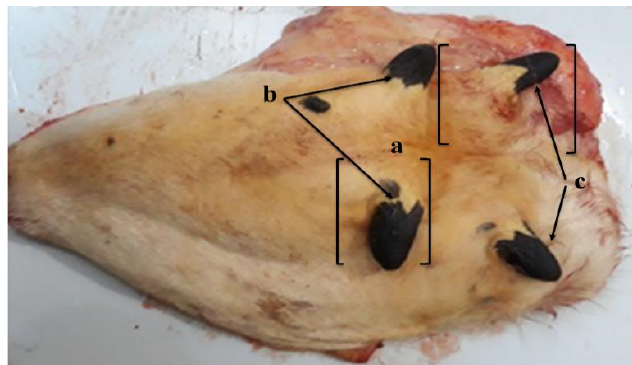
Figure 1. Photograph of ventral view in non-lactating udder of local Iraqi cow shows the external features: (a) intra mammary groove, (b) Fore teats of the fore quarters, (c) Hind teats of the hind quarters